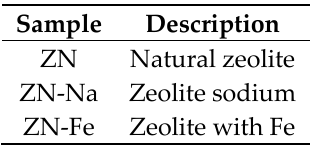
Table 1. Adsorbents